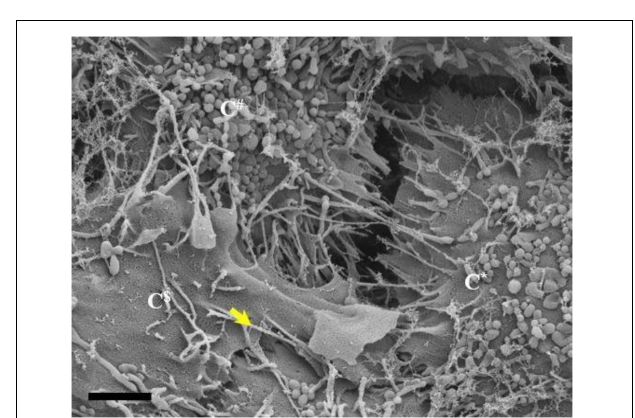
FIGURE 10 | An HRSEM micrograph of two BECs utilizing TENTs to facilitate occlusion of the PC space (Scale bar = 2,000 nm). Short developing TENTs are observed alongside fully extended TENTs, on each of the juxtaposed lateral membrane surfaces of two BECs in close proximity. TENTs are indicated by the “ yellow arrow .” The micrograph suggests, together with the additional evidence in this paper, that overlapping TENTs may have an important role in BEC membrane continuity. C* , C $ , and C # denote three different adjacent